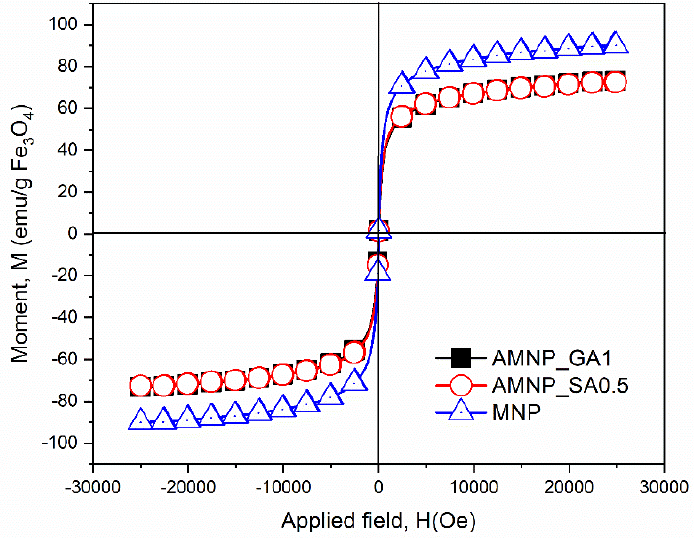
Figure 8. Magnetization curves for simple and GOx-coated MNPs.